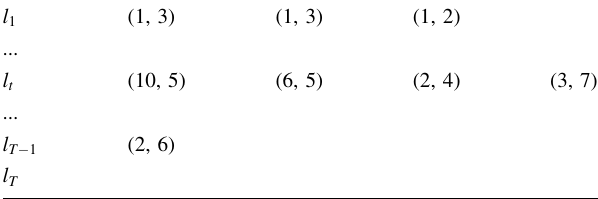
Table 1 Representation of a carsharing plan during a